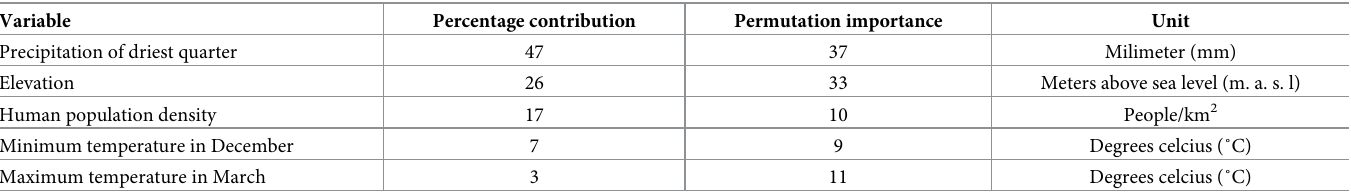
Table 1. Contribution of the five environmental predictors to the final suitability model.